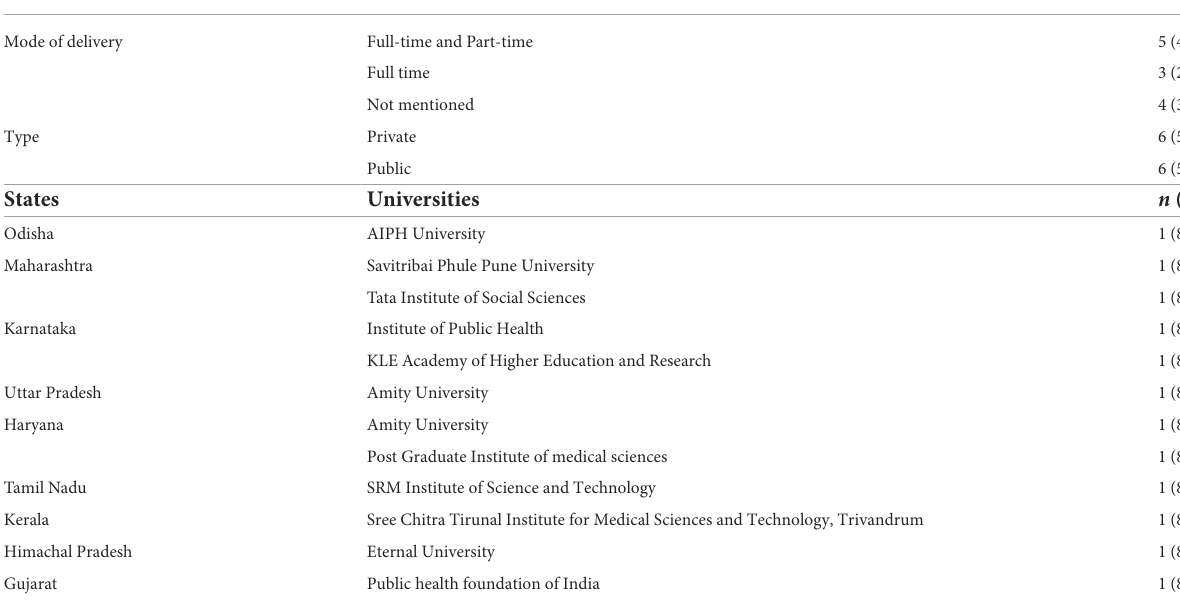
TABLE 3 Ph.D. programs in public health in different states/UTs in India ( N = 12).